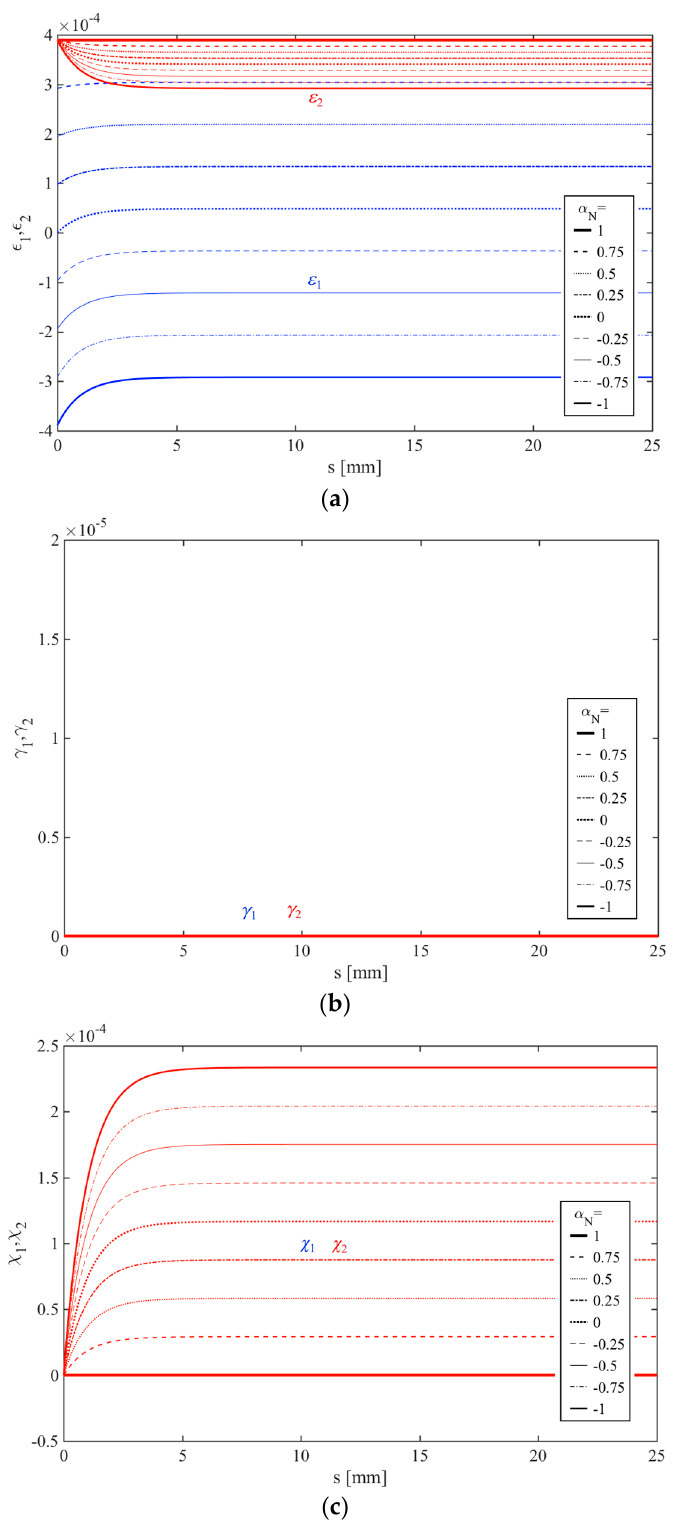
Figure 6. Effect of the axial loading on the strain field: ( a ) Axial strain; ( b ) Shear strain; ( c ) Curvature. (Isotropic specimen).